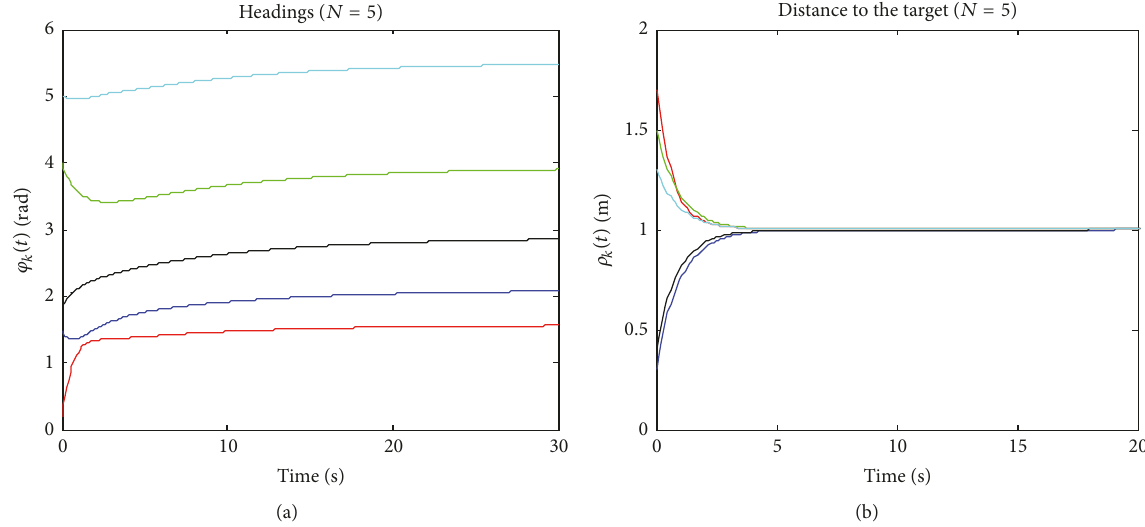
Figure 8: Trajectories with time of Figure 7. (a) Phases 𝜑 𝑘 (𝑡) of agents. (b) Distances to the target.